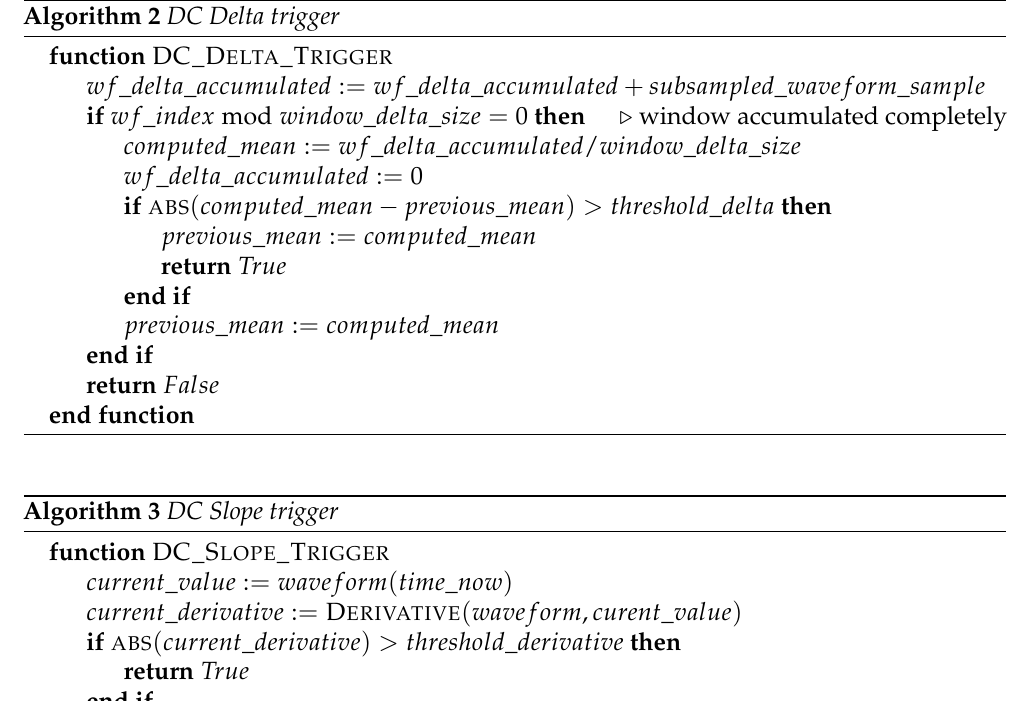
Algorithm 2 DC Delta trigger